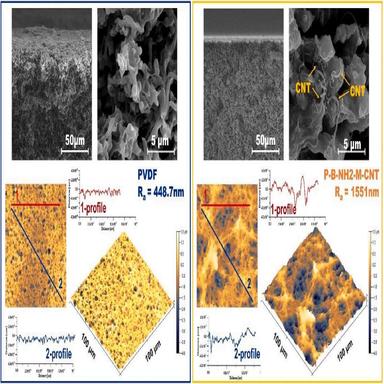
Morphological characterization with employment of SEM and AFM (2D and 3D images) Left – PVDF, right – PVDF-B-NH2-M-CNT membrane.